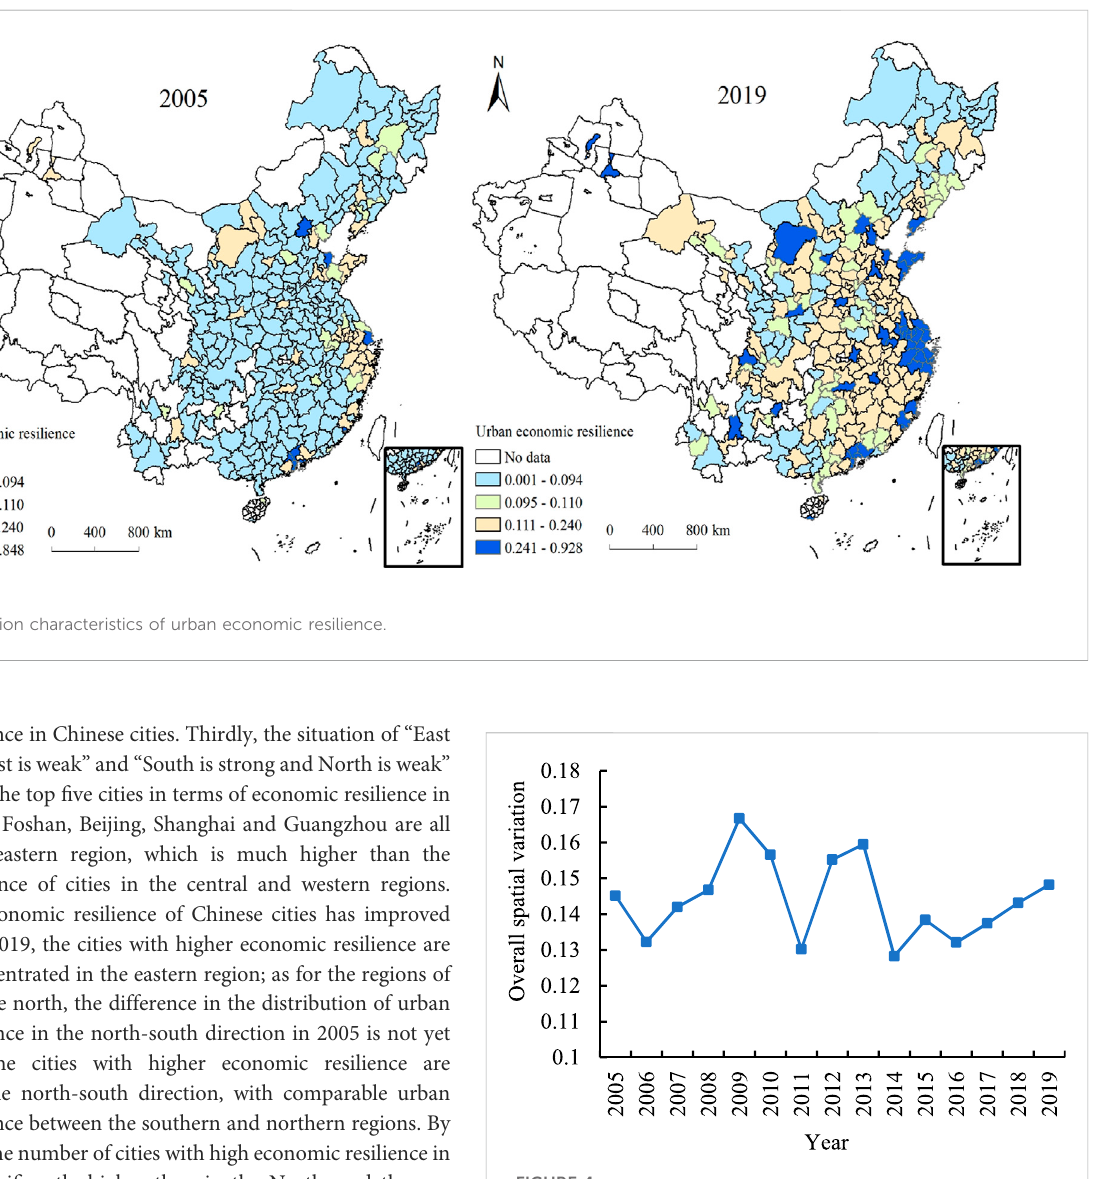
FIGURE 4 Overall variation in economic resilience of Chinese